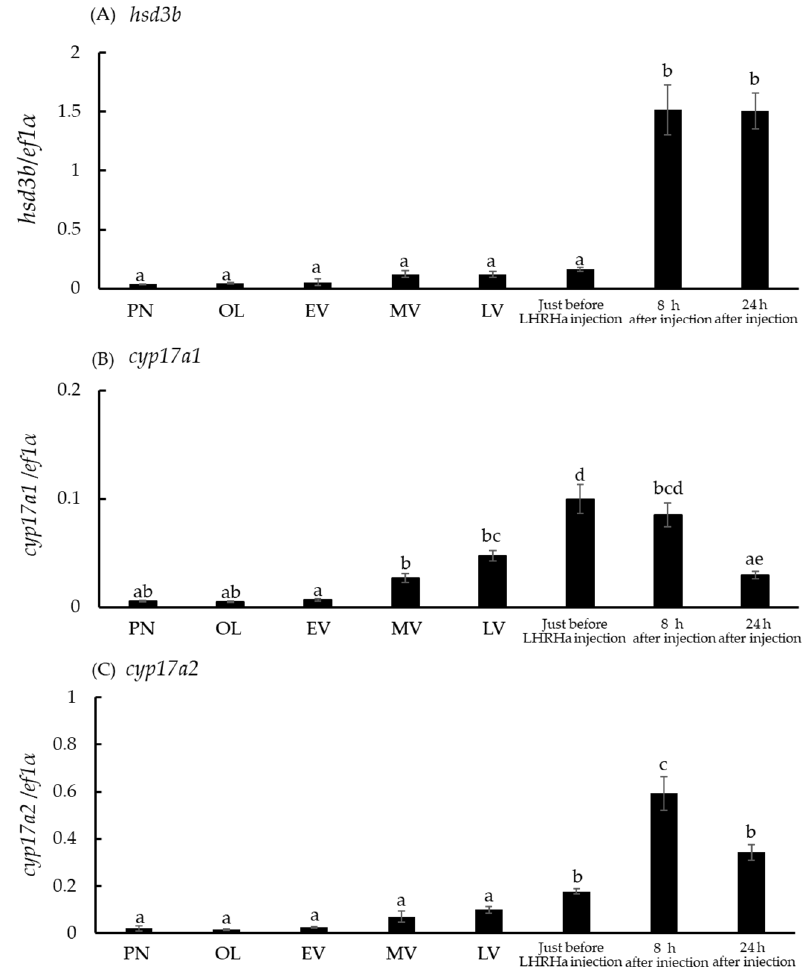
Figure 7. hsd3b, cyp17a1 and cyp17a2 expression in ovarian follicles. Expression levels in the perinucleolus stage ( n = 3), oil droplet stage ( n = 4), early-vitellogenic stage ( n = 4), mid-vitellogenic stage ( n = 4), and late-vitellogenic stage ( n = 6), and in the ovarian follicles collected just before injection ( n = 11), 8 h after first injection ( n = 5), and 24 h after first injection ( n = 11). Only those individuals were assessed that reached ovulation after LHRHa injection. ( A ), ( B ), and ( C ) indicate the hsd3b , cyp17a1 and cyp17a2 mRNA levels, respectively. PN, perinucleolus stage; OL, oil droplet stage; EV, early-vitellogenic stage; MV, mid-vitellogenic stage; LV, late-vitellogenic stage. Different letters represent a significant difference among groups ( p < 0.05).